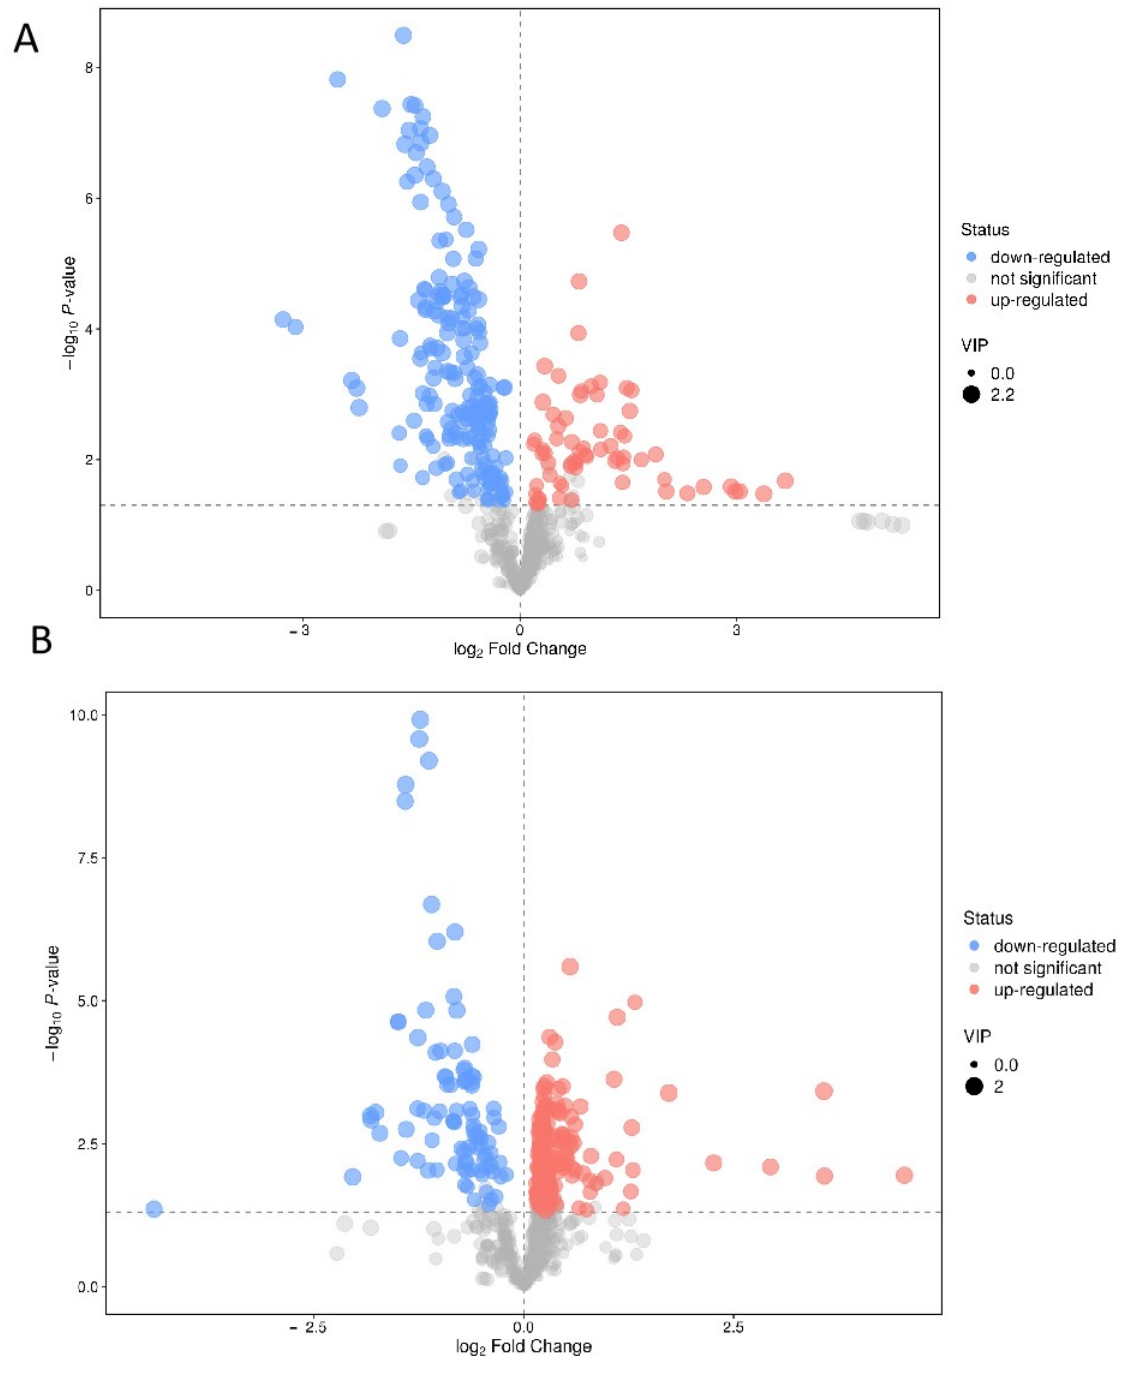
Figure 2. Volcano plots of the untargeted metabolomics under the positive model ( A ) and the negative model ( B ) according to the criteria FC > 1.5 and p <